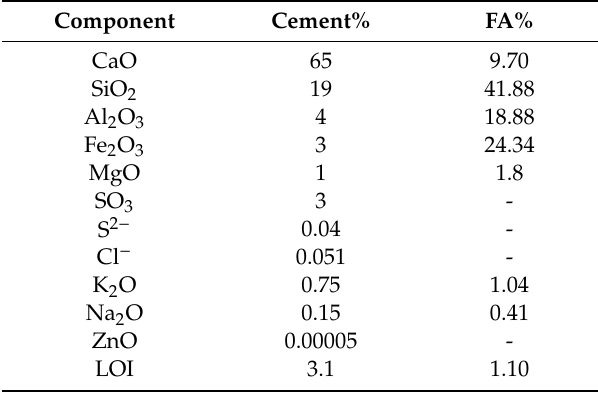
Table 1. Elemental composition of materials